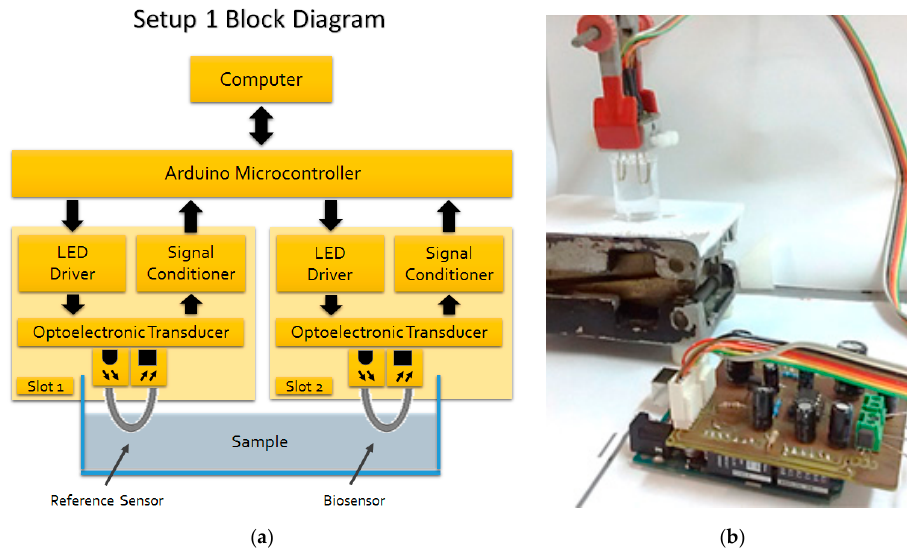
Figure 4. ( a ) Setup 1 block diagram. There are two slots, one for the reference sensor and the other one for the bacteria sensing sensor; ( b ) Setup 1